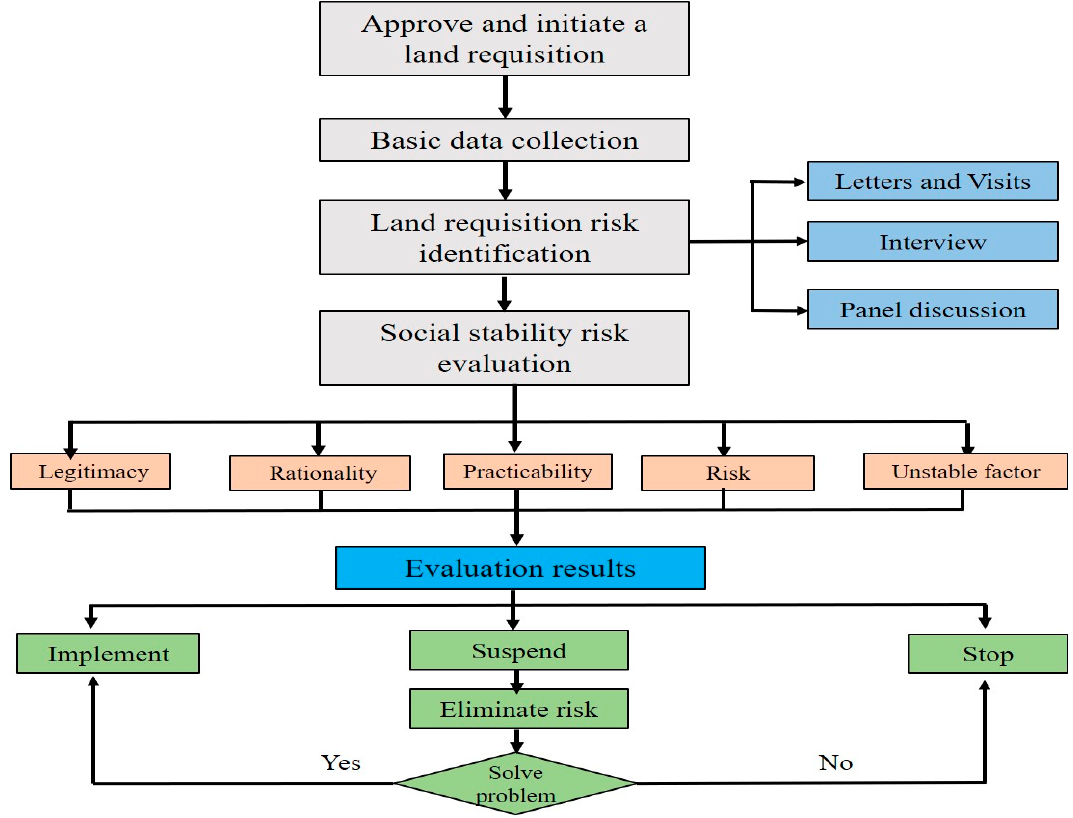
Figure 5. The procedures of the land expropriation risk assessment system in China [69].